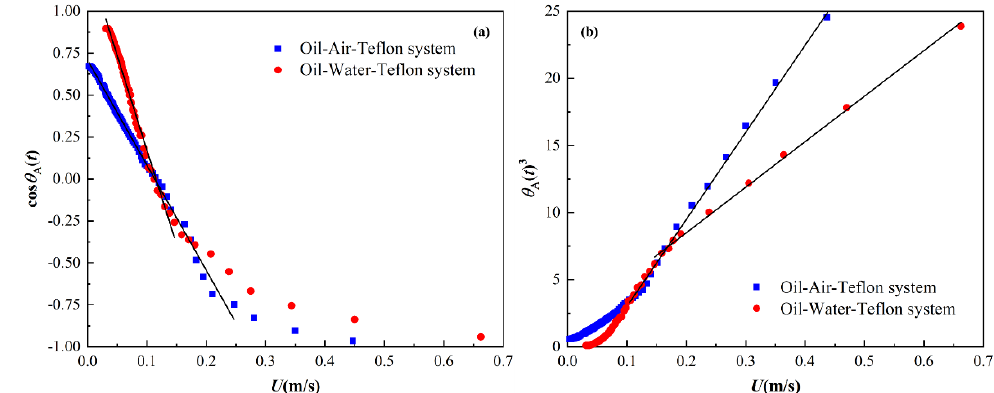
Figure 6. Relationship between TPCL velocity ( 𝑈 ) and advancing dynamic contact angle ( 𝜃 A (𝑡) ) during the spreading of oil droplets on the Teflon surface in different media environments under the MKT and HD model frameworks, respectively. The scattered dots represent the experimental data, and the solid lines represent the fitting results of MKT model ( a ) and HD model ( b ), respectively.